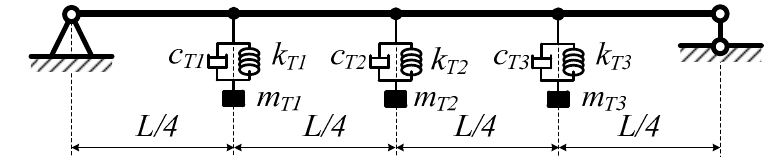
Figure 5. Beam with three TMDs. Table 1. Variation of the first natural frequencies as a function of the m T2 / m 0 ratio.